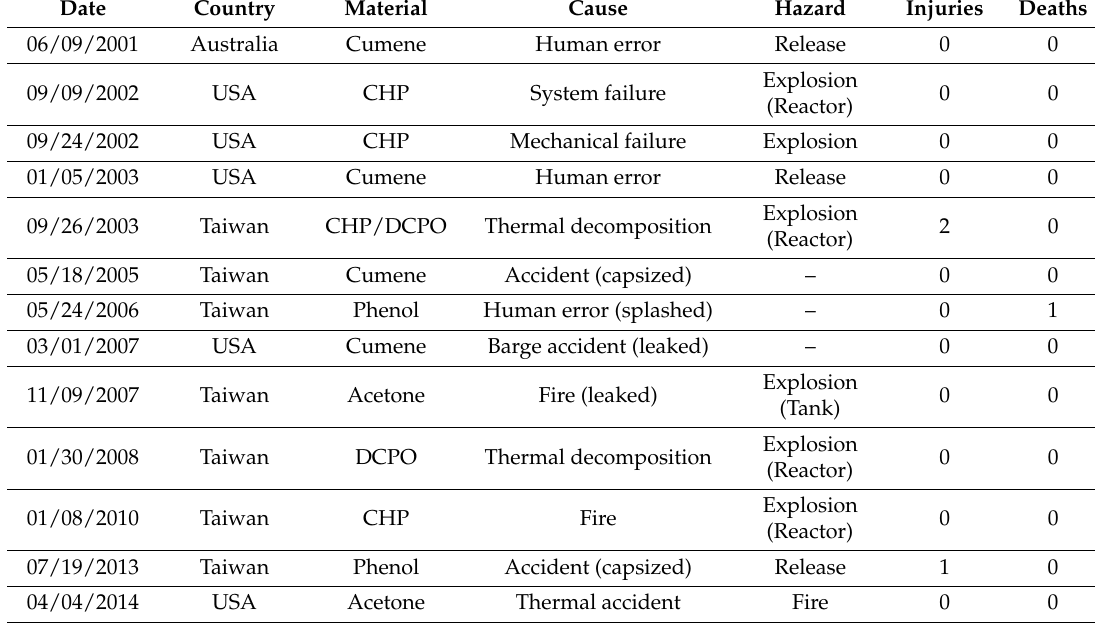
Table 1. List of relevant chemical disasters worldwide since 2001.